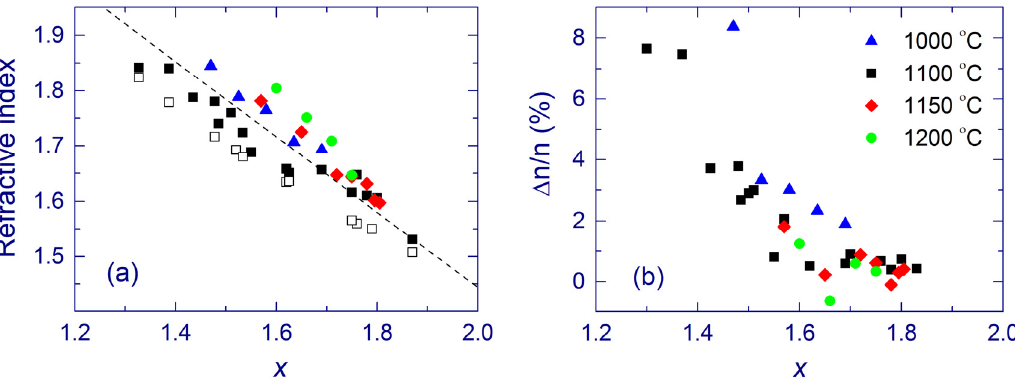
Figure 4. ( a ) TE refractive index and ( b ) birefringence of SiO x films annealed at 1000 °C (triangles), 1100 °C (squares), 1150 °C (diamonds), and 1200 °C (circles) as a function